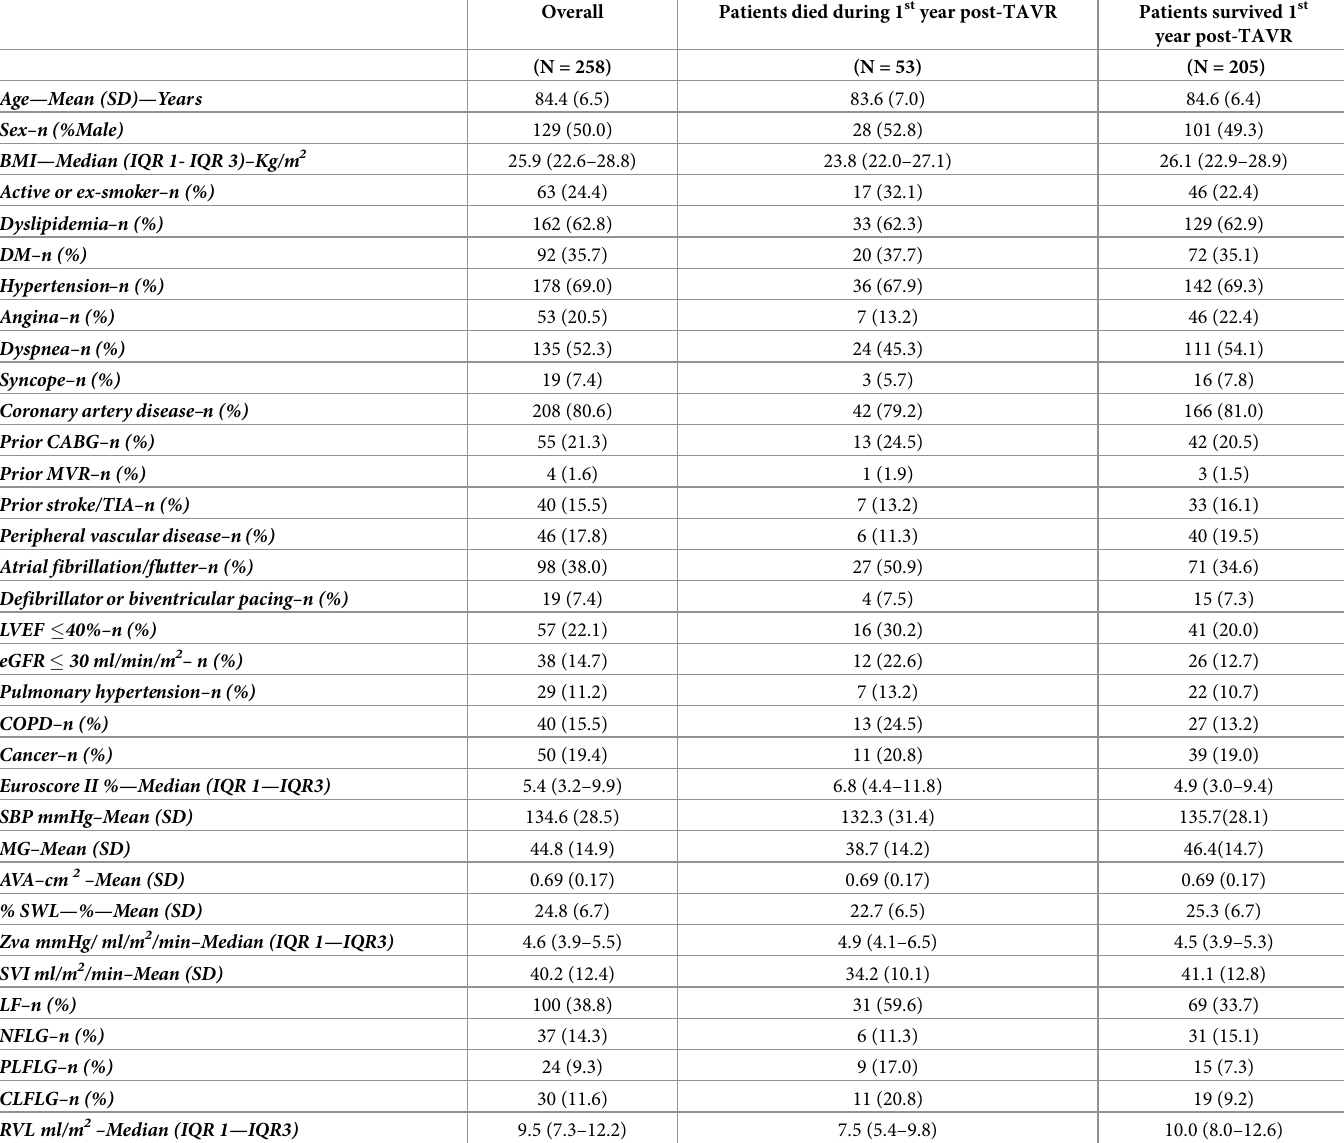
Table 1. Baseline demographic, hemodynamic and procedural characteristics of study cohort. Overall Patients died during 1 st year